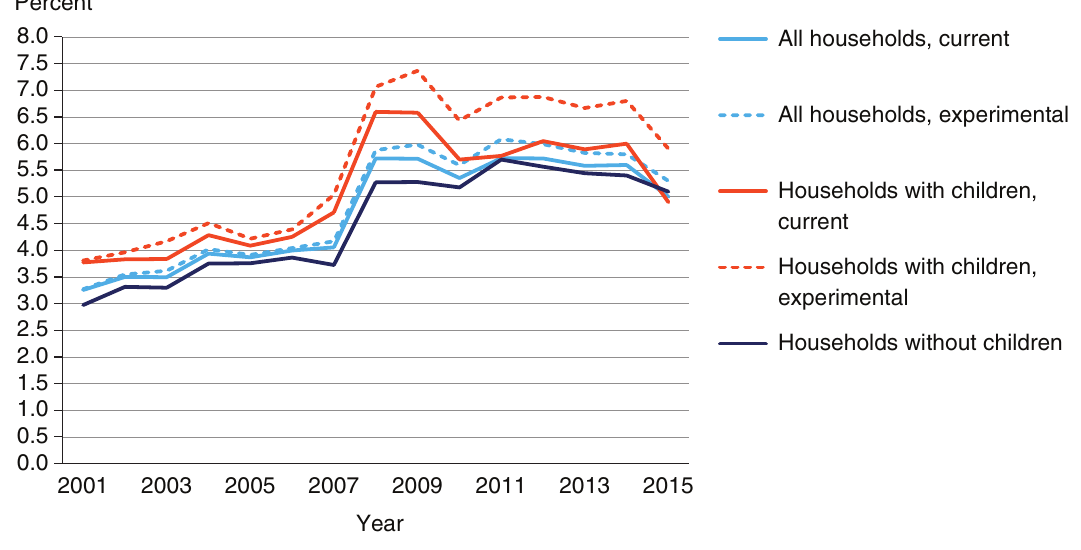
Prevalence of very low food security based on current and experimental classification methods